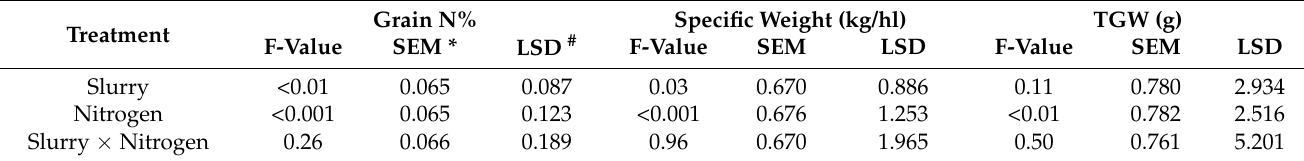
Table 7. Straw yields (t/ha) for both 2016/17 and 2017/18. Table 8. REML analysis of 2016/17 grain quality parameters.